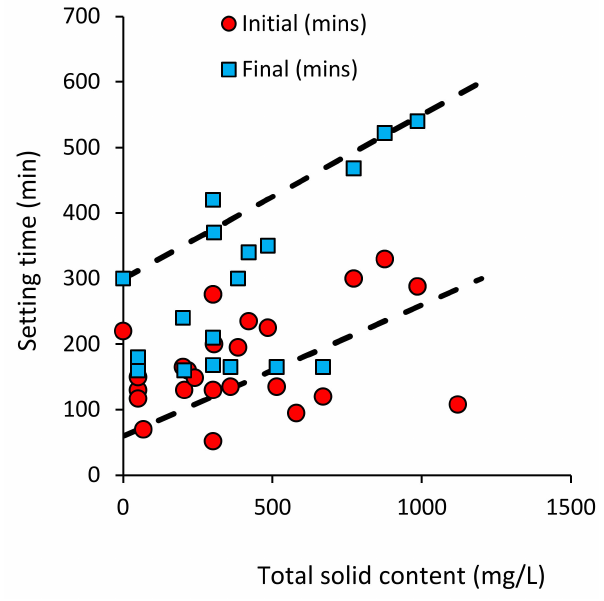
Figure 5. Effect of the total solid concentration on the setting time of